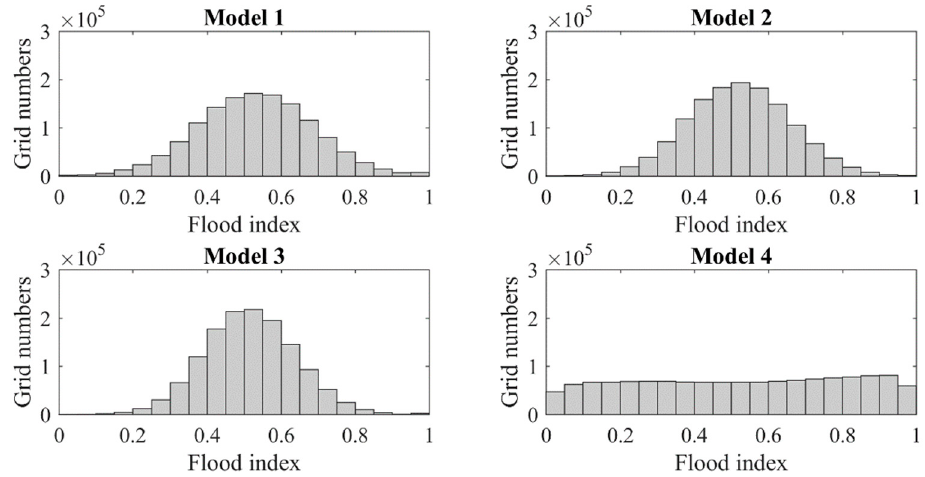
Figure 6. Histogram of Flood index in different models. (Model 1: LSSVM + LN, model 2: LSSVM + RBF, model 3: LSSVM + PL, model 4: LR).